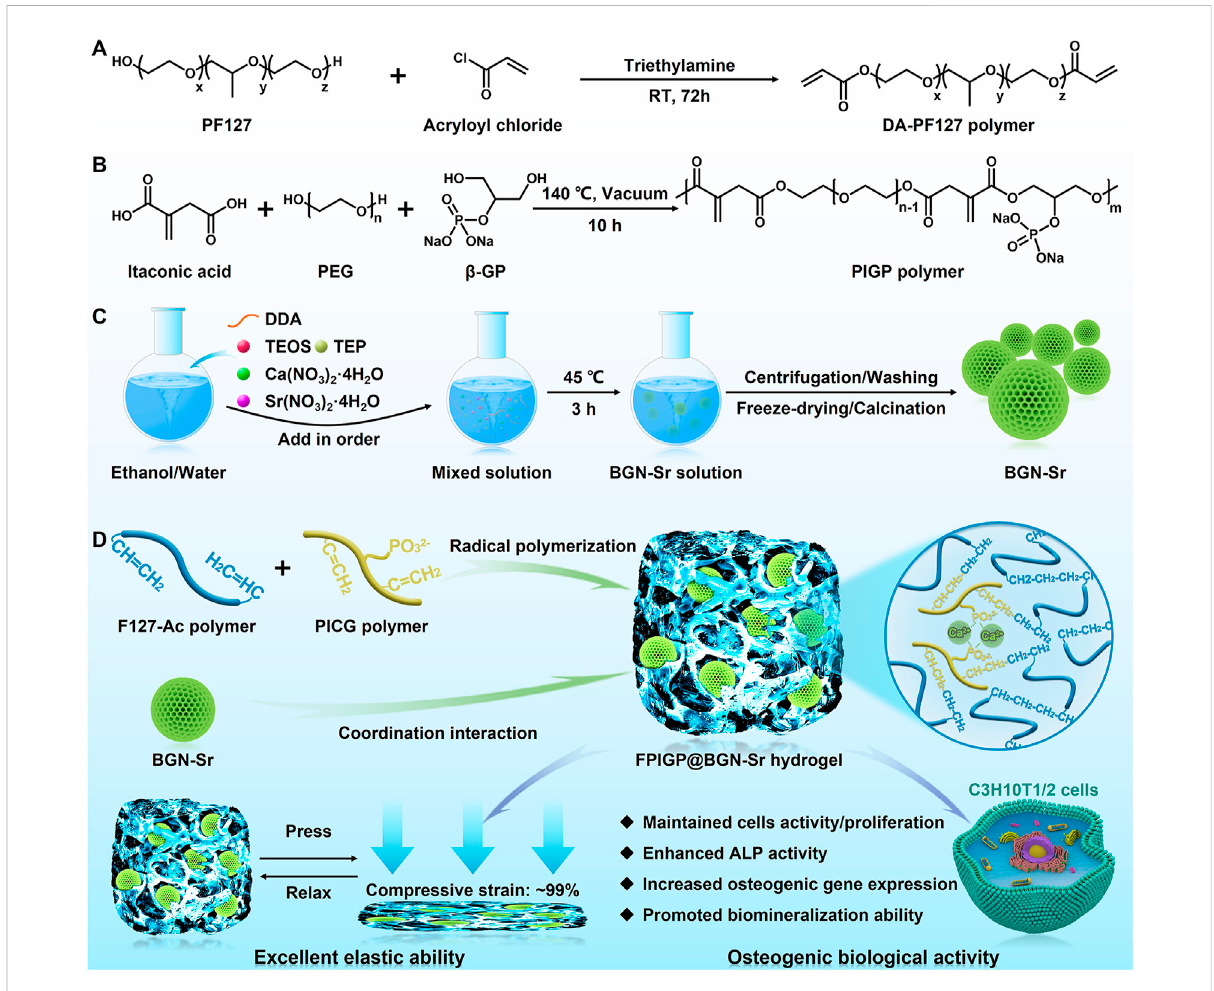
FIGURE 1 Schematic illustration showing the preparation of the FPIGP@BGN-Sr hydrogel to promote osteogenic differentiation of C3H10T1/2 cells. (A) The synthesis of DA-PF127 polymer. (B) The synthesis of PIGP polymer. (C) The fabrication of BGN-Sr. (D) The preparation of the FPIGP@BGN-Sr hydrogel and its